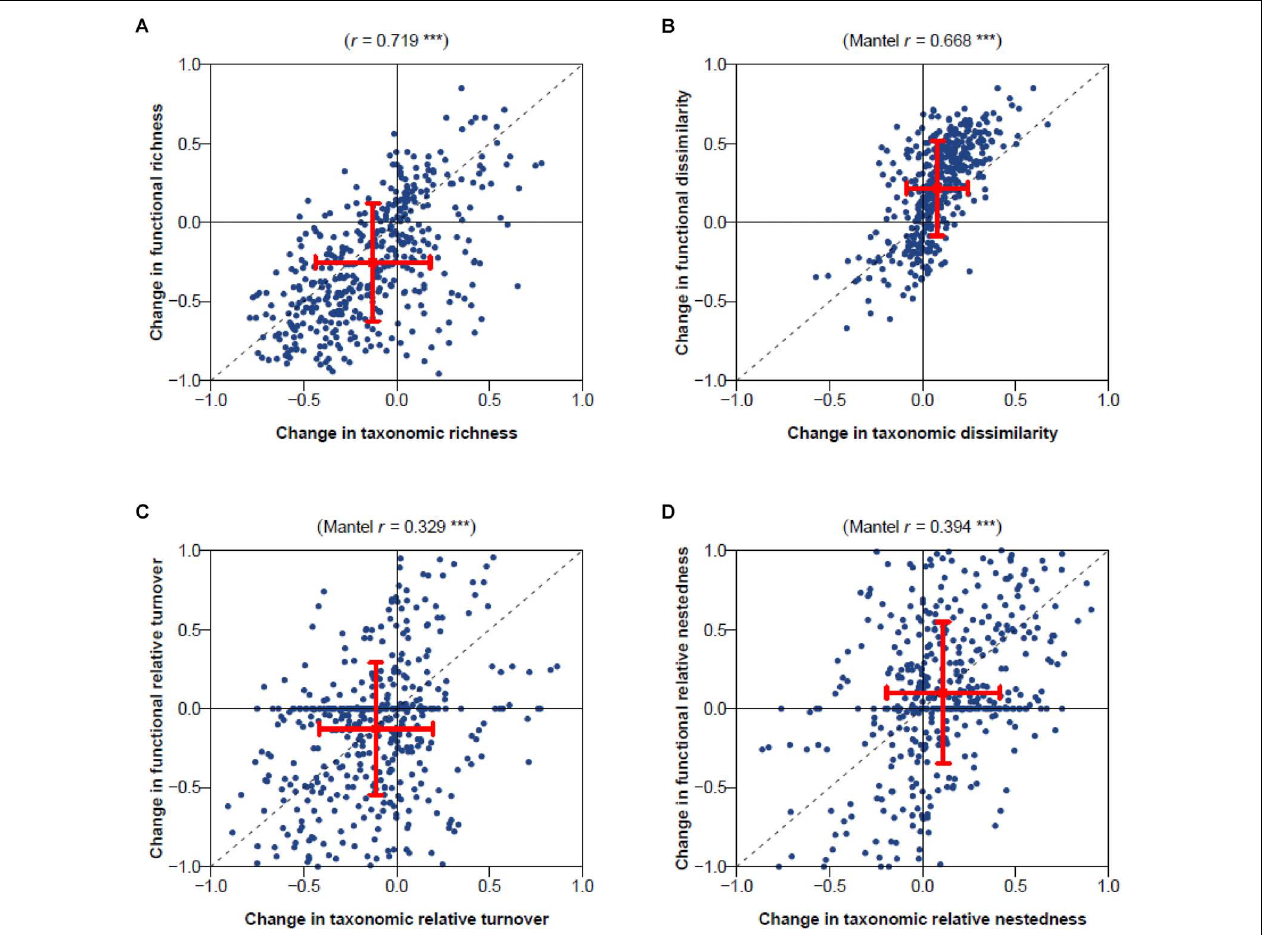
FIGURE 3 | Comparison of changes in taxonomic and functional diversity for (A) richness, (B) total dissimilarity, and its (C) turnover and (D) nested components. Pearson’s correlation coefficient and associated simple linear regression test is provided at the top of the richness panel ( A ; ∗∗∗ P < 0.001). Spearman’s correlation coefficient and associated Mantel permutation test are provided at the top of other panels ( B–D ; ∗∗∗ P <